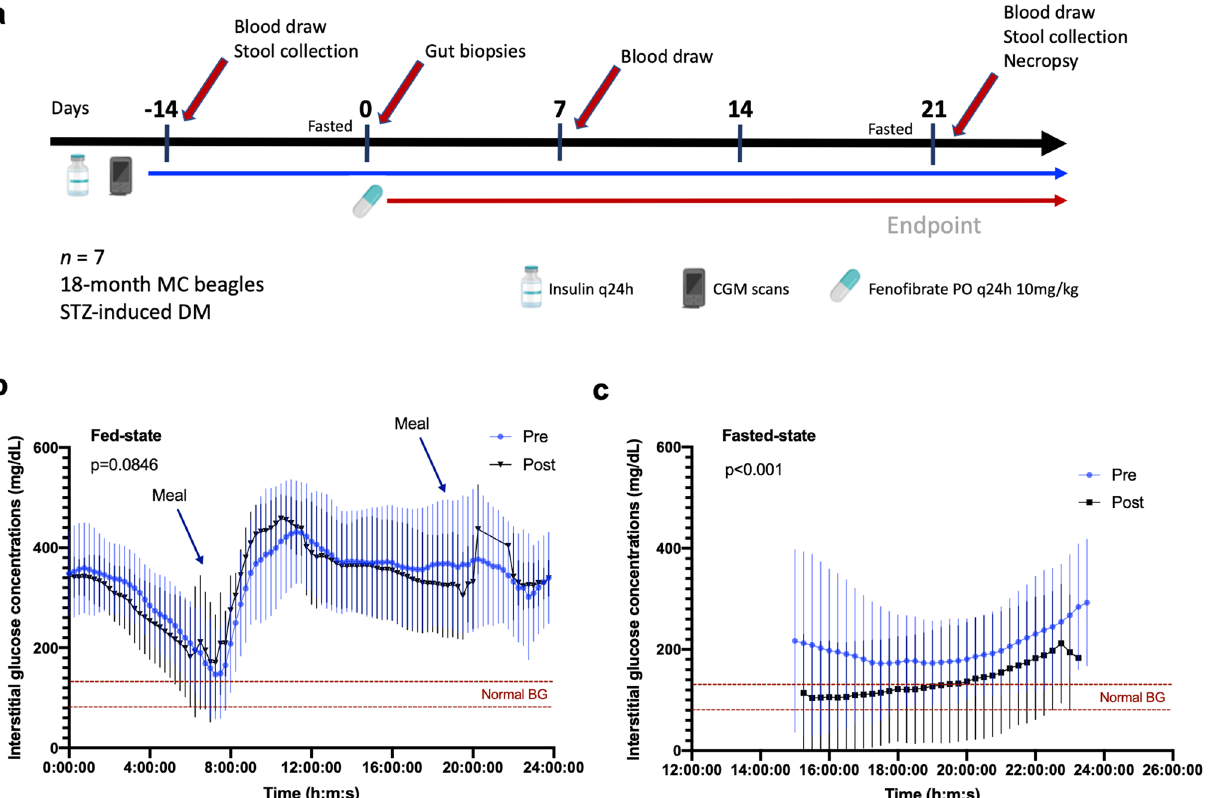
Figure 1. Fenofibrate reduces fasting interstitial glucose (IG) concentrations in diabetic dogs. ( a ) Diabetic dogs treated with fenofibrate (10 mg/kg by mouth) for 21 days. ( b ) Mean IG measurements over 72 h after 3 weeks of fenofibrate administration compared to pre-treatment concentrations. ( c ) Comparison of fasted mean IG measurements after fenofibrate administration compared to baseline concentrations. All data represent the average of 7 dogs evaluated in 15-min increments. Means ± SD are plotted. P -values were determined by the Wilcoxon test. Image icons were created with